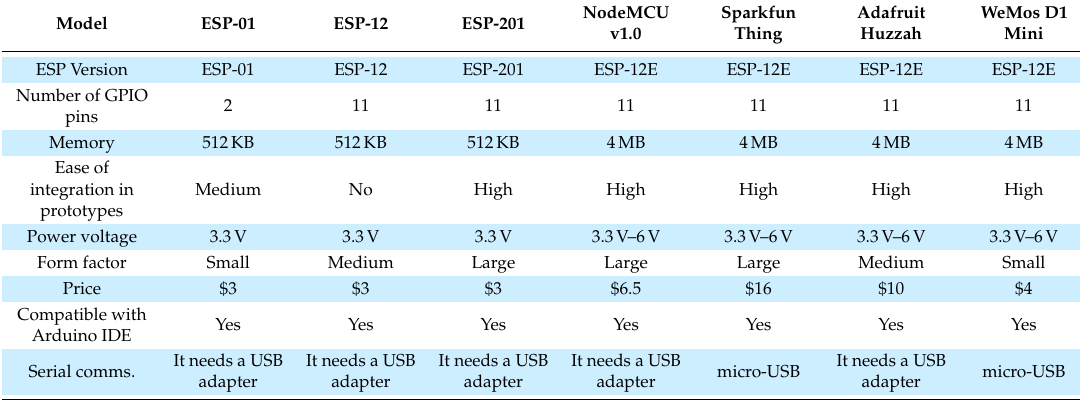
Table 6. Main characteristics of ESP8266-based